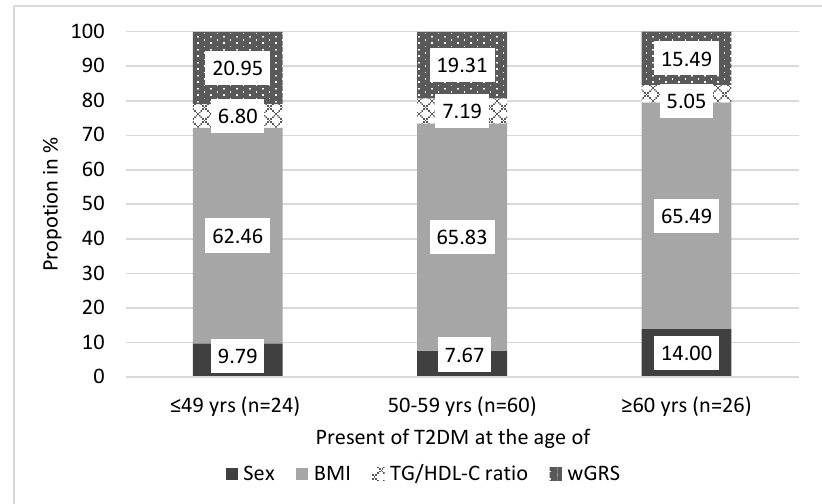
Figure 5. The proportion of components (sex, BMI, TG/HDL-C ratio, and wGRS) of Table 2. diabetic subgroups of the Hungarian general population by age groups.